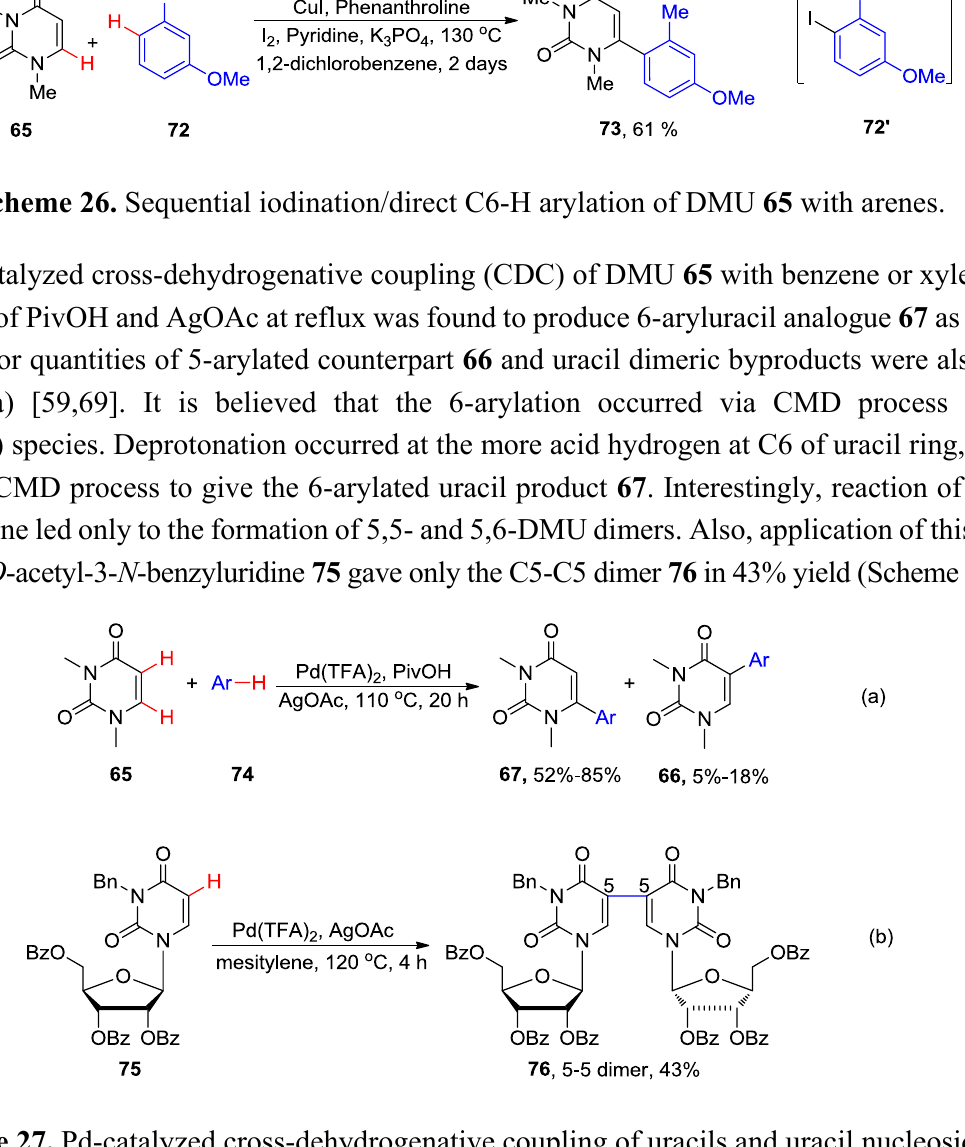
Scheme 27. Pd-catalyzed cross-dehydrogenative coupling of uracils and uracil